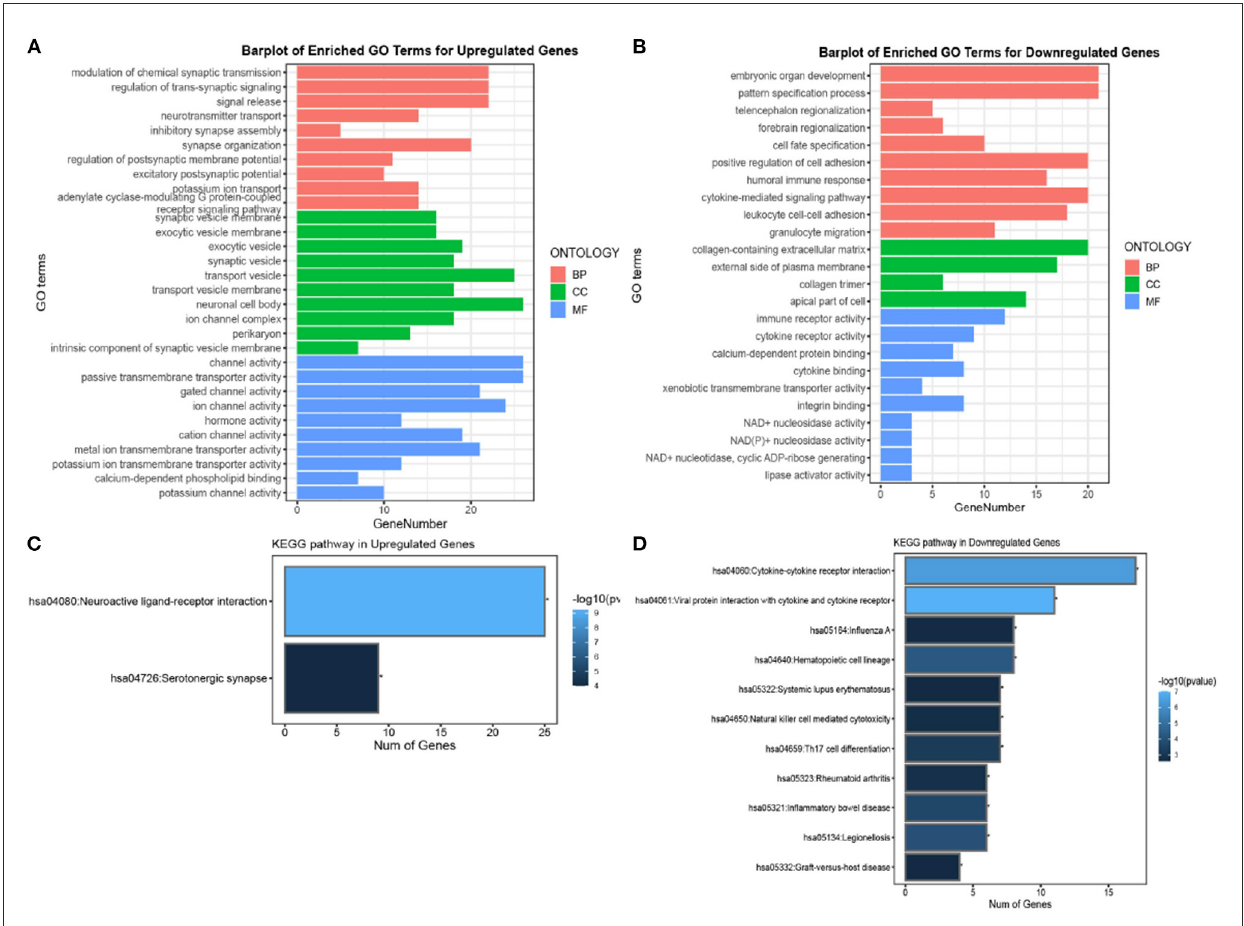
FIGURE2 Gene ontology (GO) and Kyoto Encyclopedia of Genes and Genomes (KEGG) enrichment analysis of DEGs in AD. (A, B) Top 10 GO results in terms of molecular function, cellular component, and biological process category for upregulated and downregulated genes, respectively. (C, D) The significant KEGG pathways for upregulated and downregulated genes, respectively. The length and colors represent the number of genes and the log10 P -values.